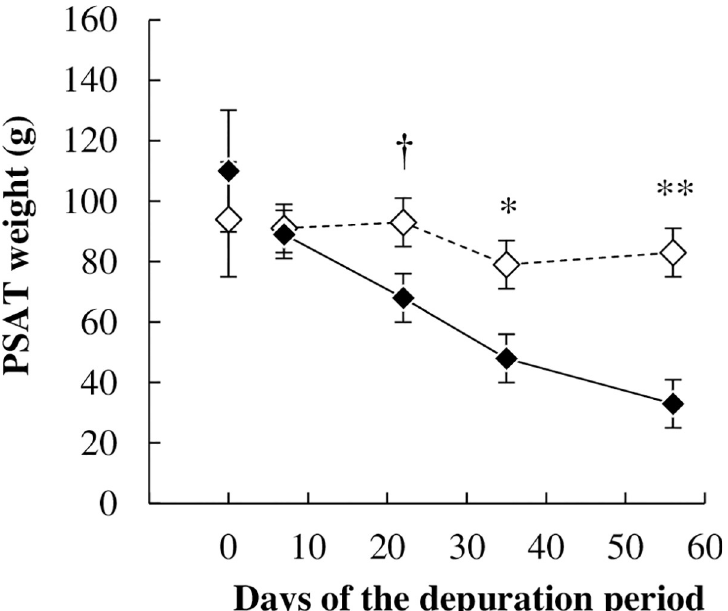
Fig 3. Time pattern kinetics of pericaudal subcutaneous adipose tissue (PSAT) weight in ewes receiving a control well-fed and non-supplemented treatment (CTL: ^ ) or an underfed and mineral oil supplemented treatment (UFMO: ♦ ). Each point represents the least-squares mean, and error bars indicate SEM except at day 0, for which they represent the mean and SE. The � and �� symbols indicate a significant ( P � 0.05 and P � 0.01, respectively) and † a tendency toward significance ( P � 0.10) for treatment effect on the considered day.